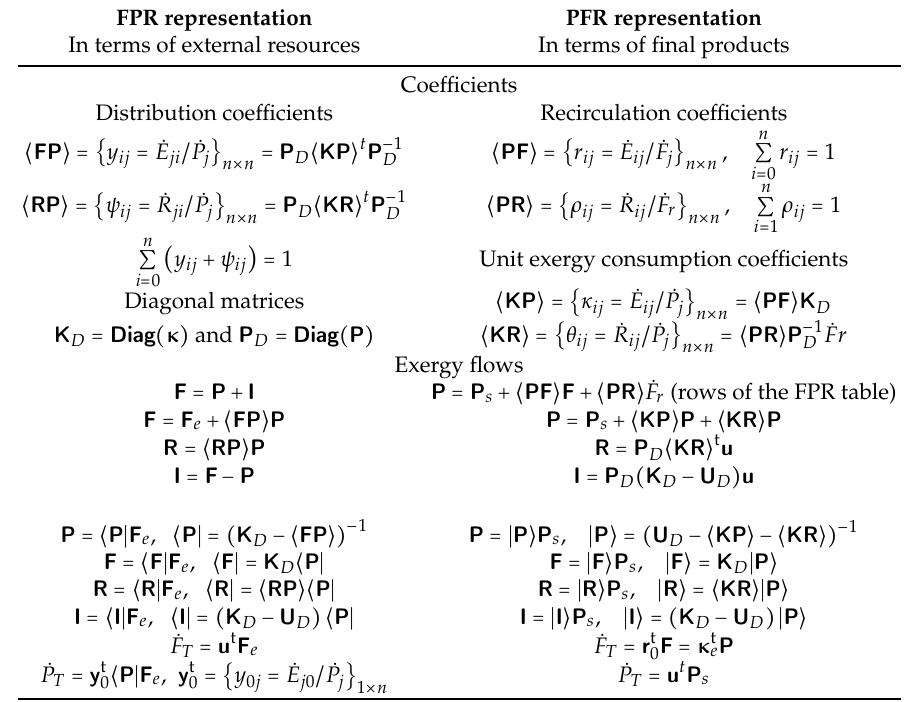
Table A4. FPR and PFR symbolic representations (adapted from